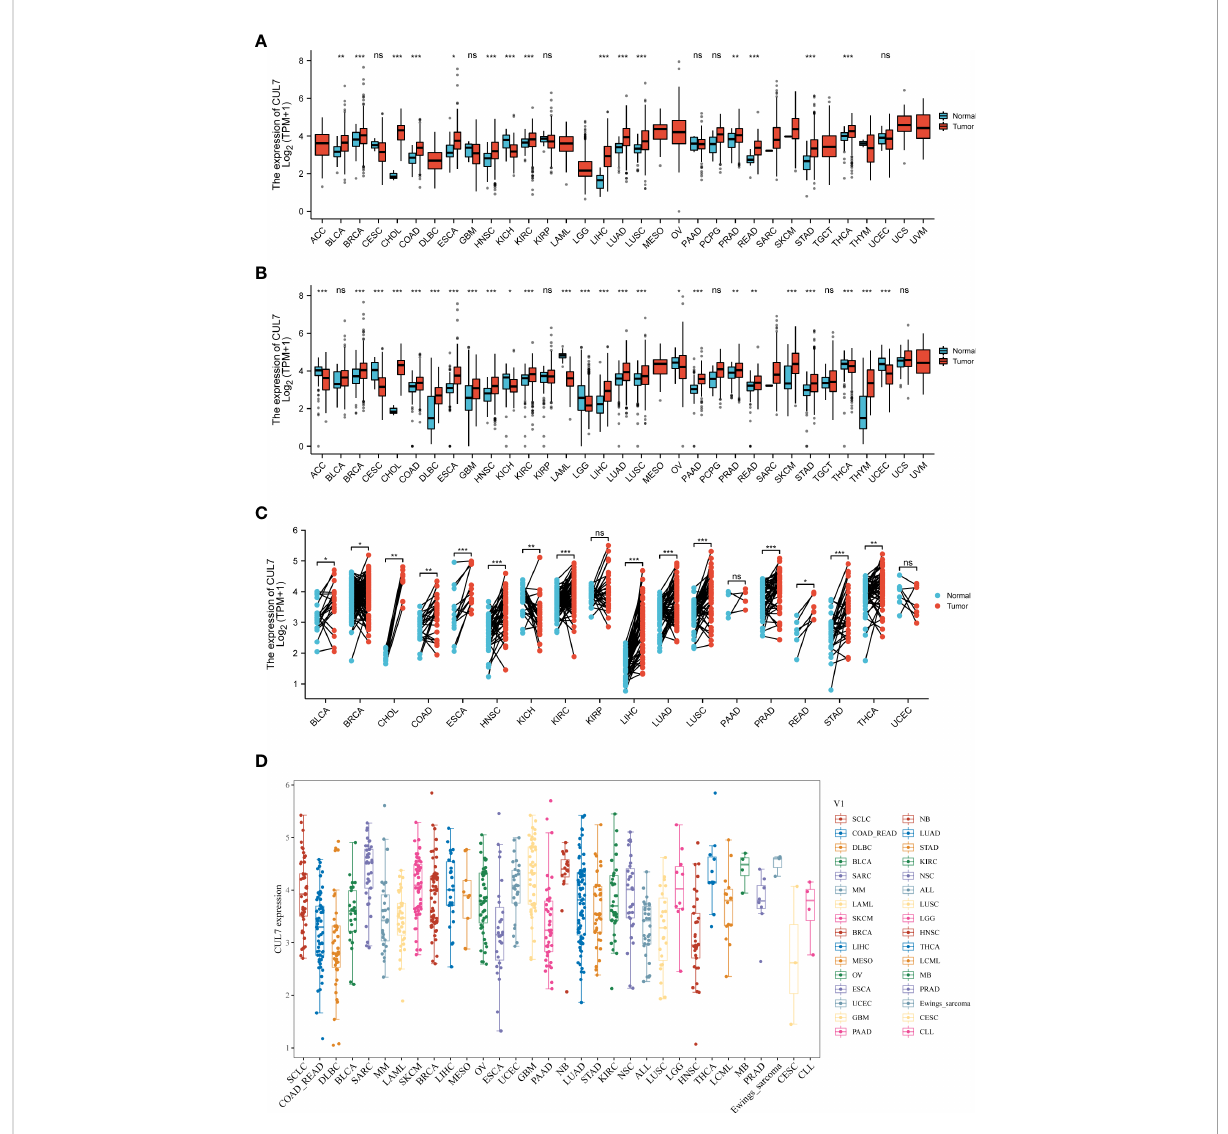
FIGURE 1 Differential expression of CUL7. (A) CUL7 expression in 33 tumors in TCGA. (B) CUL7 expression in 33 tumors in TCGA and GTEx. (C) Differential expression of CUL7 in paired tumors and adjacent normal tissues in TCGA. (D) CLU7 expression in various cancer cell lines from the CCLE database. Ns, non-signi fi cant, *P < 0.05; **p < 0.01; ***P <